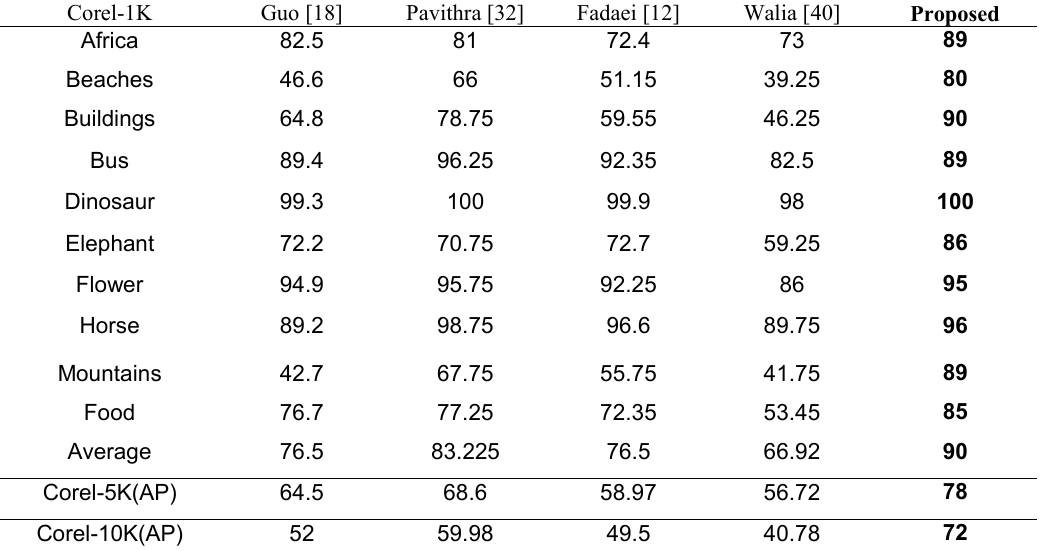
Table 2. Comparison of average precision of proposed method with other methods for Corel datasets Corel-1K